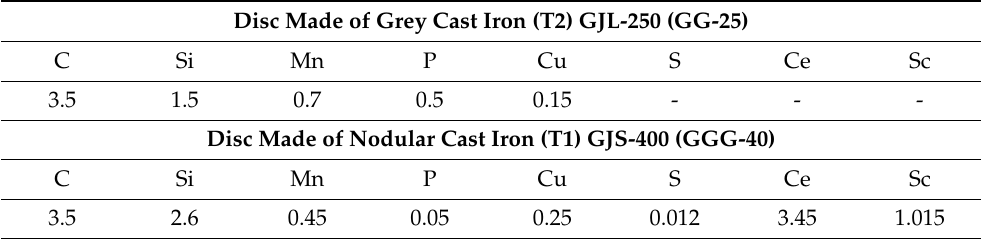
Table 2. Chemical composition in % of elements for cast iron discs used during the tests.